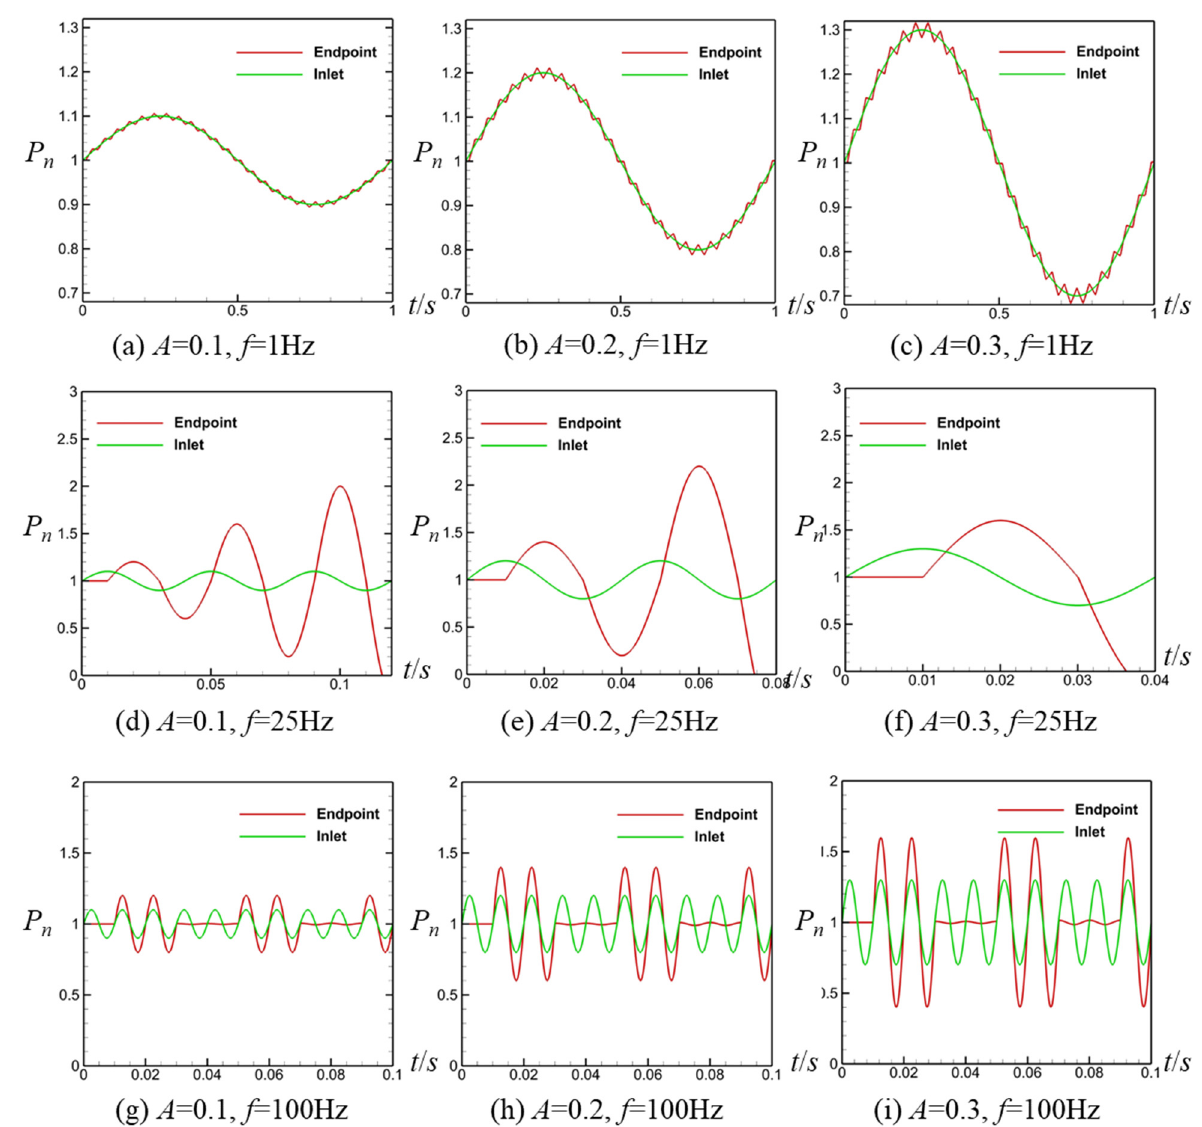
Figure 11. Normalized pressure–time curves where L x = 10 m and a = 1000 m/s: ( a ) A = 0.1, f = 1 Hz; ( b ) A = 0.2, f = 1 Hz; ( c ) A = 0.3, f = 1 Hz; ( d ) A = 0.1, f = 25 Hz; ( e ) A = 0.2, f = 25 Hz; ( f ) A = 0.3, f = 25 Hz; ( g ) A = 0.1, f = 100 Hz; ( h ) A =0.2, f = 100 Hz; ( i ) A = 0.3, f = 100 Hz.